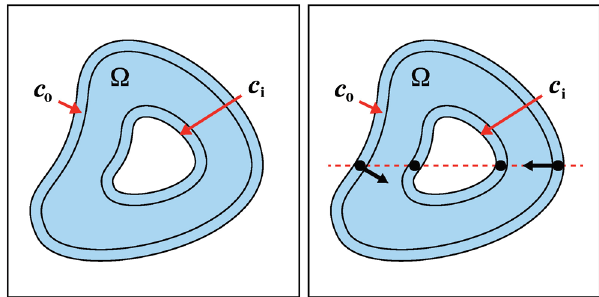
Fig. 7 Left: the domain, Ω, and boundaries ( c o and c i ) of P i . Right: the gradient orientation on c o (arrows) and zero-gradient on c i (dots).